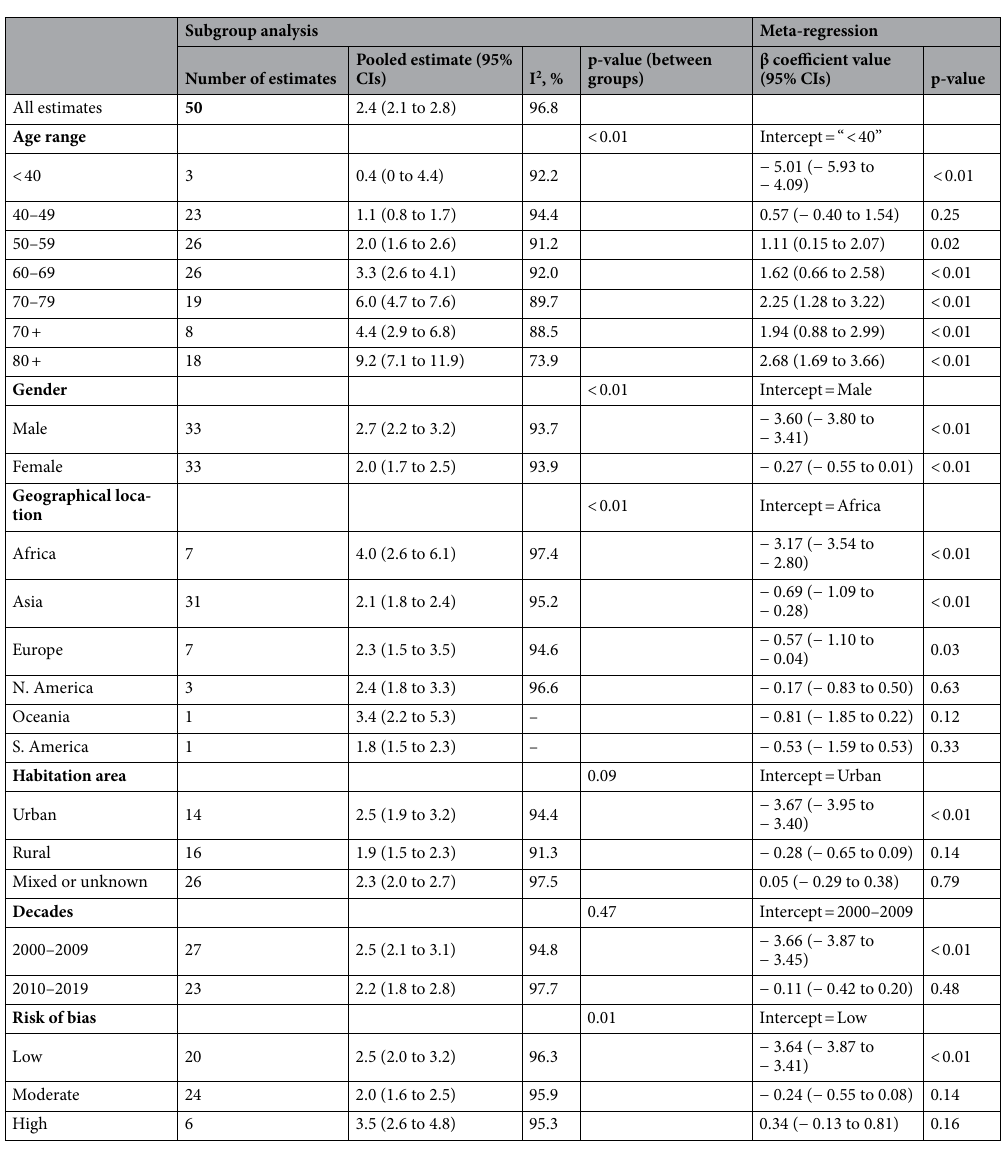
Table 1. Results of subgroup analyses and meta-regression analyses based on age, gender, geographical location, habitation area, decades and risk of bias. S. America South America, N. America North